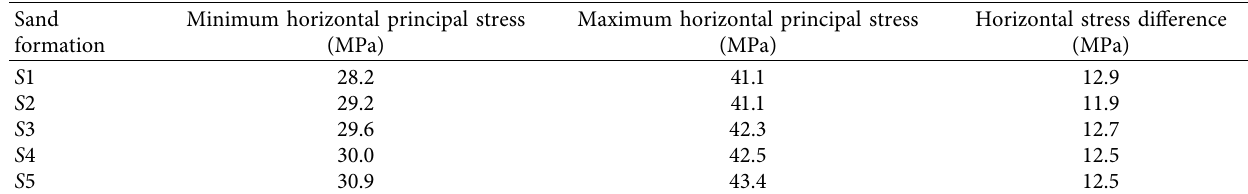
Table 2: Statistical table of in-situ stress data of sand group S 1 ∼ S